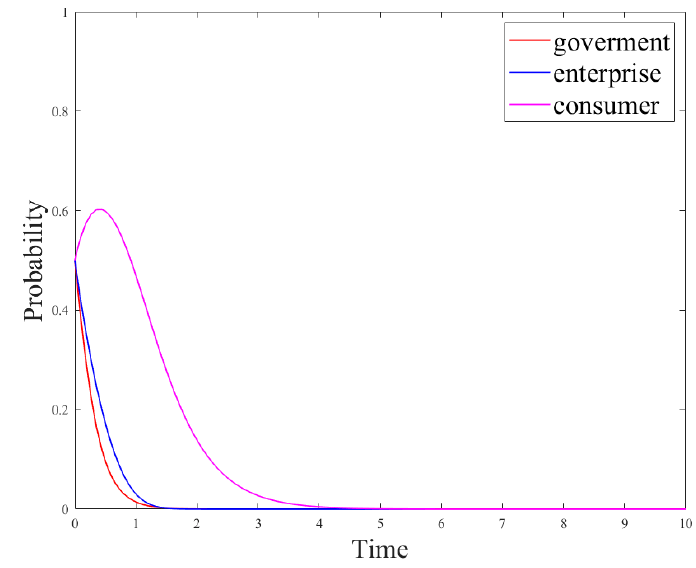
Figure 5. Evolution results under Scenario 1.